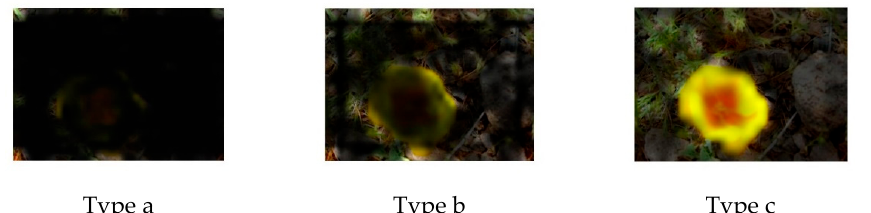
FFP(x, y) regarding the D-determined optimal model Figure 13. FFP(x, y) of Figure 12.